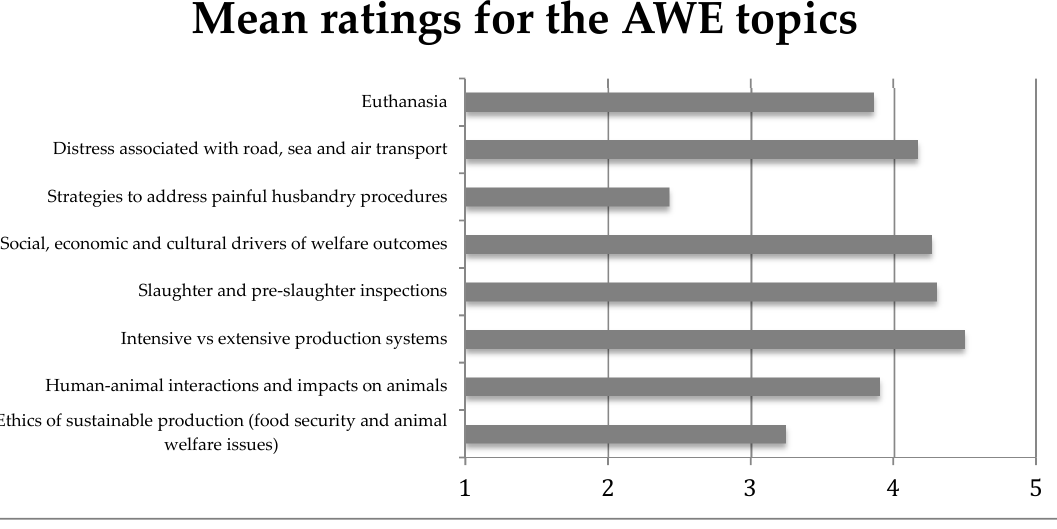
Figure 1. Mean ratings (1 = extremely important, 10 = least important) in answer to the question